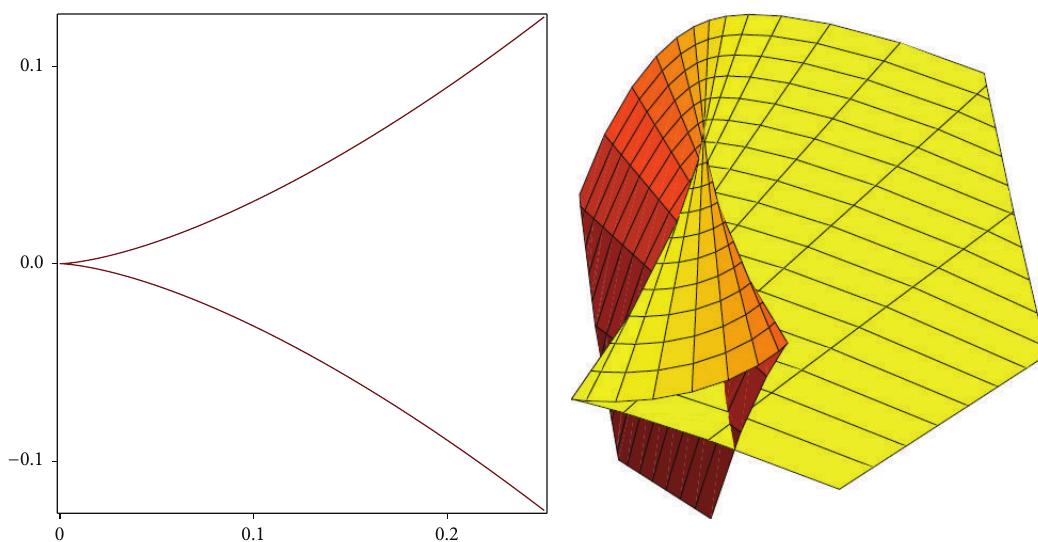
Figure 1: (2,3)-cusp and